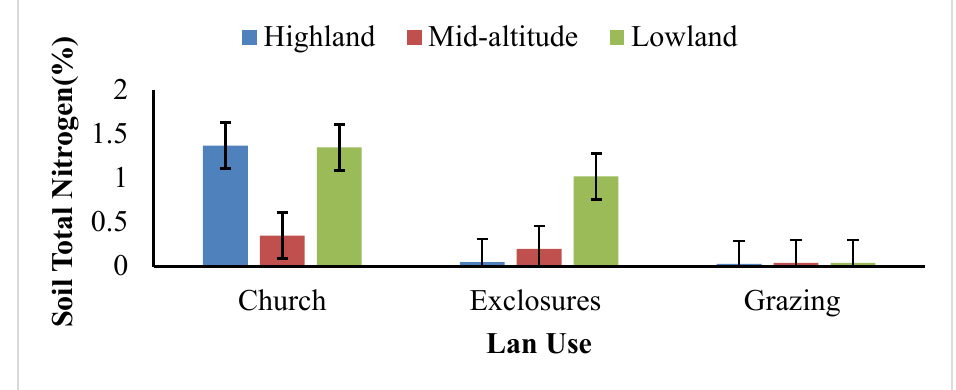
Figure 7. Soil total nitrogen in different soil depths and land use.